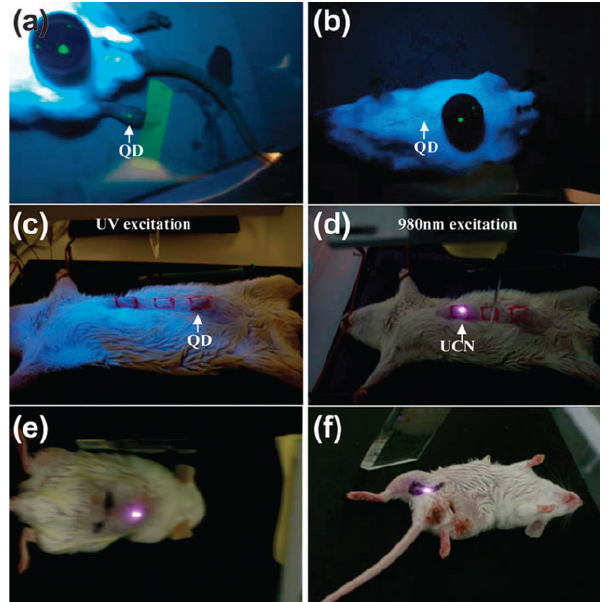
Figure 3. In vivo imaging of living rats with quantum dots (QDs) injected into the translucent skin of the foot ( a ) showing fluorescence, but not through thicker skin of